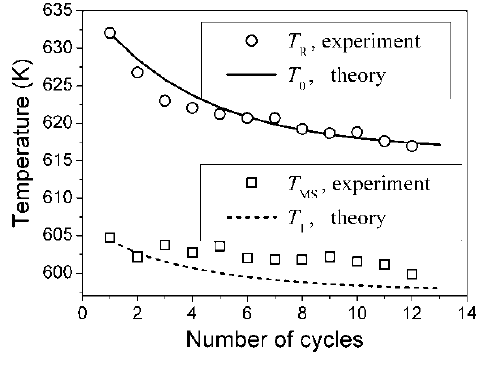
Figure 10. The influence of thermal cycling on the forward (bottom curve) and reverse (upper curve) MT temperatures of Sample